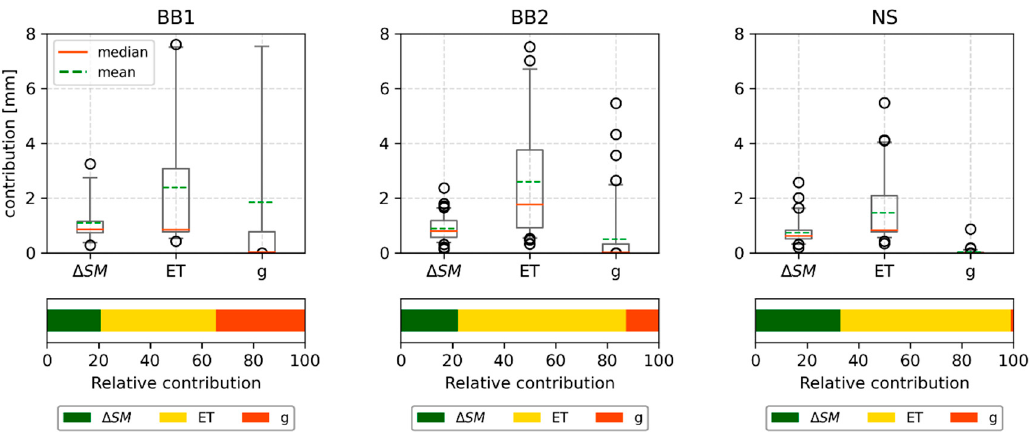
Figure 6. Contribution to the estimated irrigation water height for all individual events coming from the following components: soil moisture increase between consecutive overpasses ( ∆ SM), evapotranspiration (ET) and drainage (g). Bar plots show the mean relative contribution.